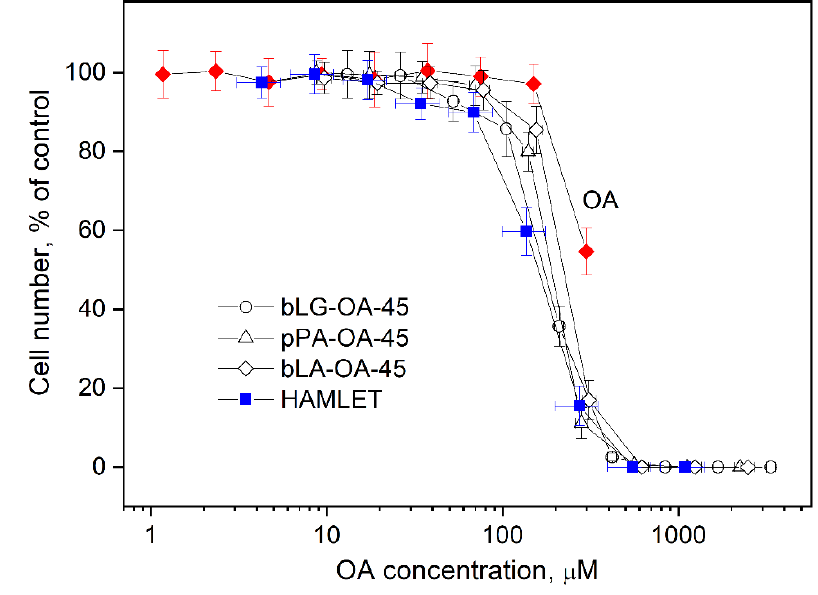
Figure 6. Viability of human larynx carcinoma cells in vitro plotted vs. concentration of oleic acid (OA) within the sample. The protein-OA complexes were prepared at 45 °C under alkaline Ca 2+ -free conditions (pH 12.0, 1 mM EDTA). bLG-OA-45 (bovine β-lactoglobulin, open circles), pPA-OA-45 (pike parvalbumin, open triangles), bLA-OA-45 (bovine α-LA, open diamonds), human α-lactalbumin made lethal to tumor cells (HAMLET) (solid squares), OA (oleic acid, solid diamonds).